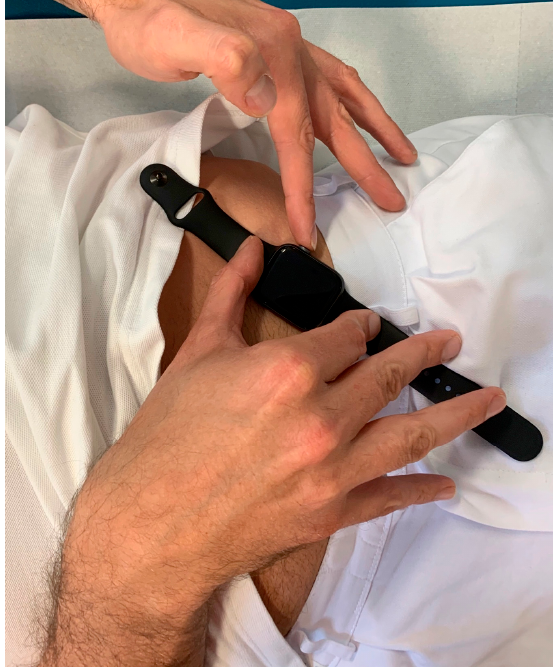
Figure 3. Registration of Einthoven lead III between the left lower abdominal region and the left index finger.